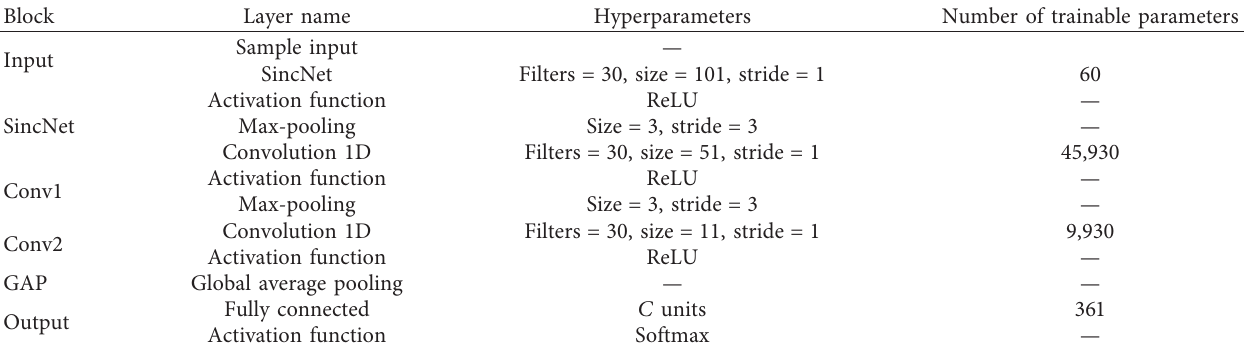
Table 3: Implementation details of the 1D CNN